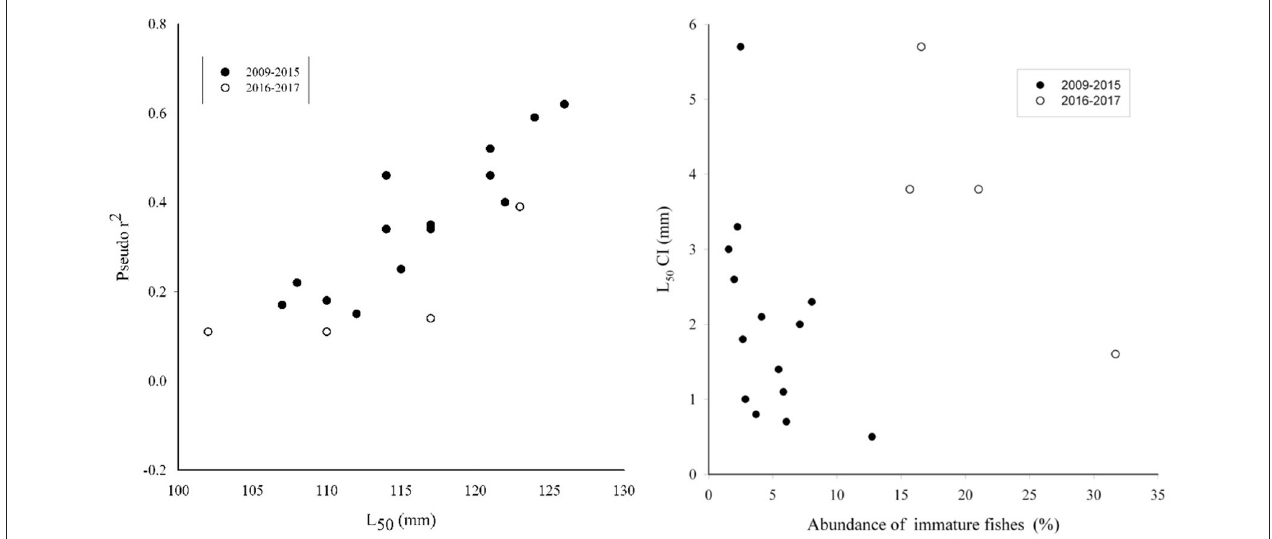
FIGURE 6 | Scatterplot of length at first maturity (L 50 , mm) vs . corresponding Pseudo-r 2 and the scatterplot of confidence intervals (L 50 CI, mm) of the ogive fitting vs . the corresponding abundance of immature fishes by year (right panel). Data from male and female European sardine were plotted separately, but black and white dots were used to distinguish two different study period (2009–2015 and 2016–2017) according to the